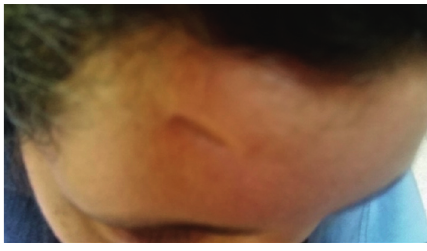
Figure 1: Scar of head injury.